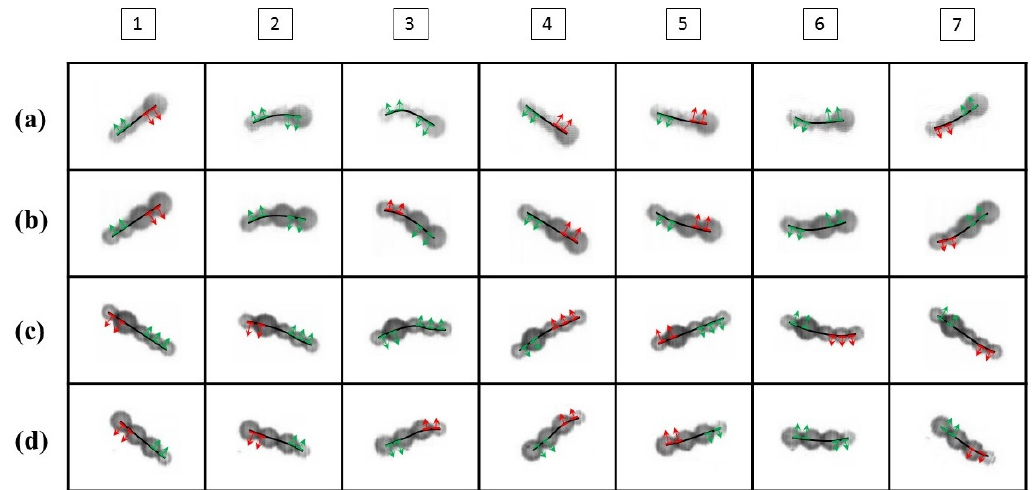
Figure 6. Sequential images of the direction of thrust for the head and tail of a swimmer within a period of oscillation for the ( a ) L1S3, ( b ) L2S2, ( c ) S1L1S3, and ( d ) L3S1 swimmers in Figure 2. The numbers at the top of the figure correspond to the number of the curve in Figure 3. The green and red arrows represent the positive and negative thrust, respectively, of the head and tail of the swimmer.